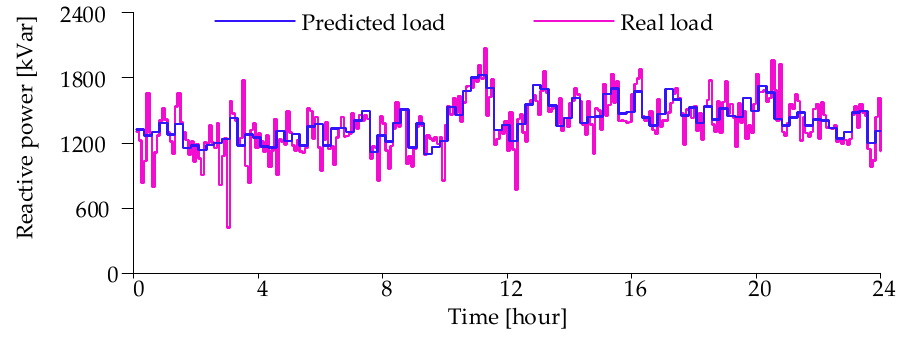
Figure 3. Daily reactive load